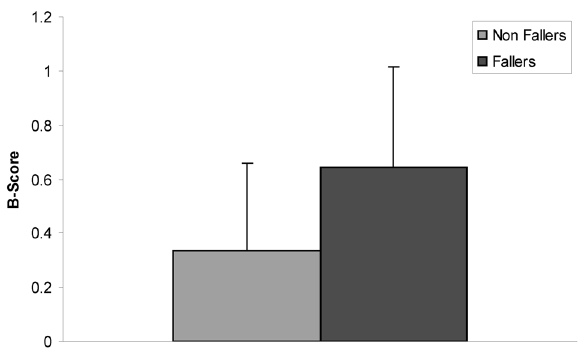
Figure 4. B-Scores of elderly subjects with and without self- reported falls. The B-score is based on an ‘‘idealized’’ postural sway profile, as established by a group of young healthy adults (B-score of zero). Those with at least one self-reported fall in the prior 6 months had a B-score of 0.645, compared to those without falls who had a B- score of 0.334 (p , 0.0001).